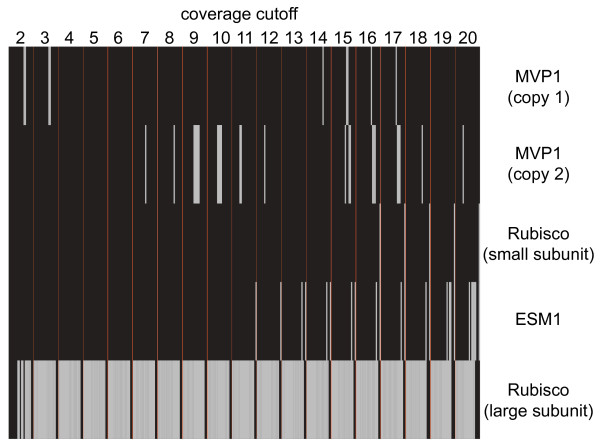
Assembly patterns in the P. fastigiatum library for five example transcripts. All 380 assemblies (coverage cutoffs 2 to 20 and k-mer sizes 25 to 63) were screened for complete transcripts of five example genes (AT1G67090, AT3G14210, two homeologous sequences of AT1G54030, and ATCG00490). If a complete transcript was present in an assembly it was marked in grey and in black otherwise.